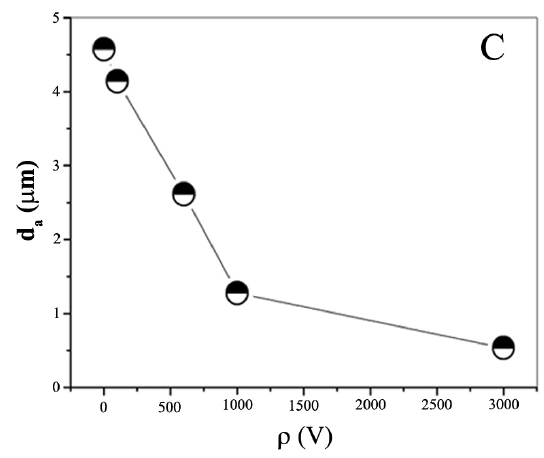
Figure 11. (A ) Illustration of the electric breath figure device; ( B ) Schematic view of the electrostatic distribution of water droplets in the electric breath figure process, with copyright permission from [95]; ( C ) Curve of the pore diameter versus the applied voltage of PS/SiO 2 chloroform solution, with copyright permission from